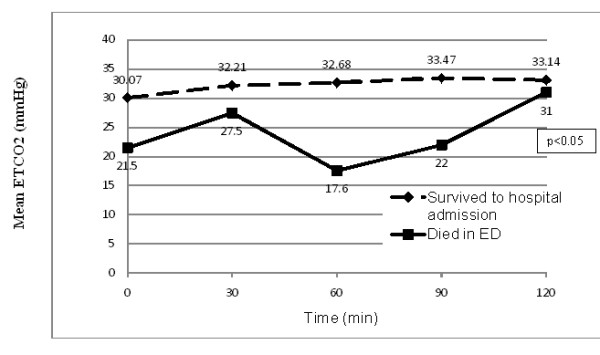
Values of ETCO2for both early mortality and survival to hospital admission..